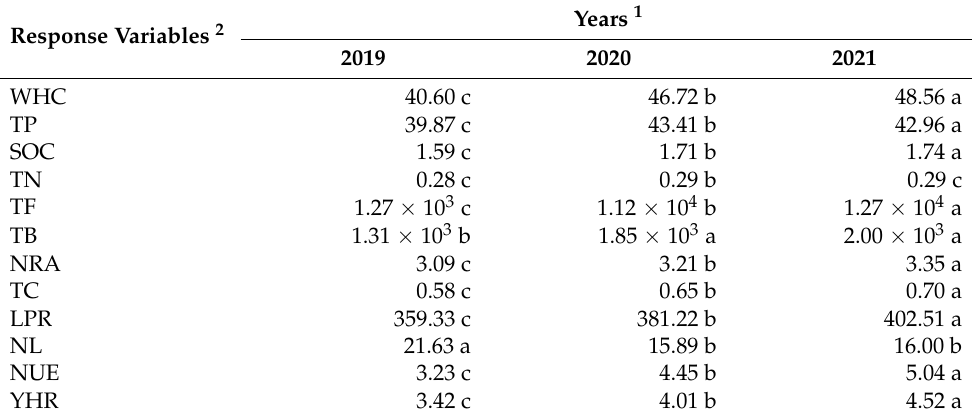
Table 4. Least square means (LS-Means) of hybrid